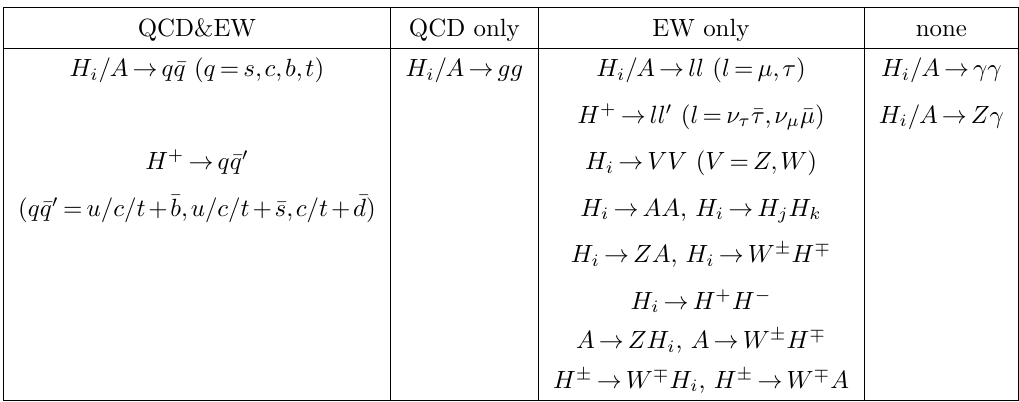
Table 4 . List of neutral CP-even ( H i ), neutral CP-odd ( A ) and charged ( H (cid:6) ) Higgs on-shell decays with the corresponding implemented corrections. The o(cid:11)-shell decays that are calculated below the threshold, H i ! (cid:22) t (cid:3) t (cid:3) , H + ! t (cid:3) (cid:22) b , H i ! V (cid:3) V (cid:3) ! 4 l , H i ! H (cid:3)